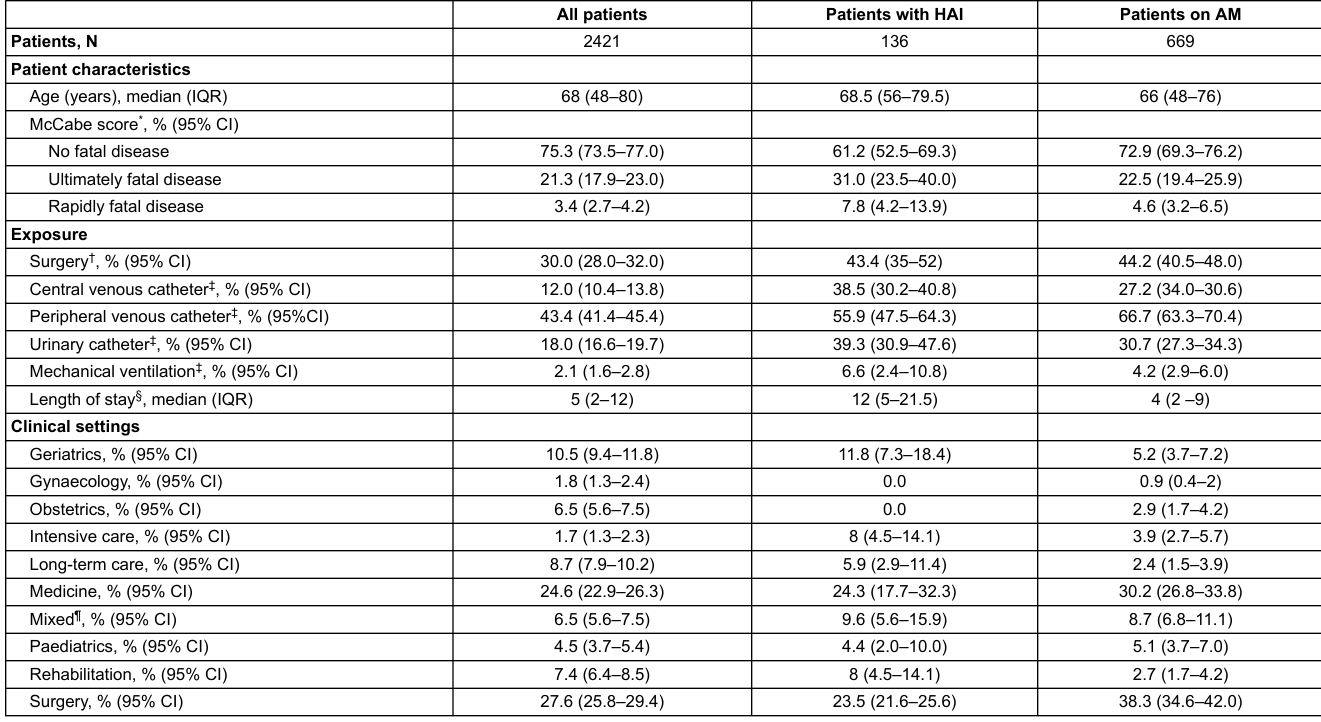
Table 1: Characteristics of patients – multicentre point prevalence survey, Switzerland 2016.